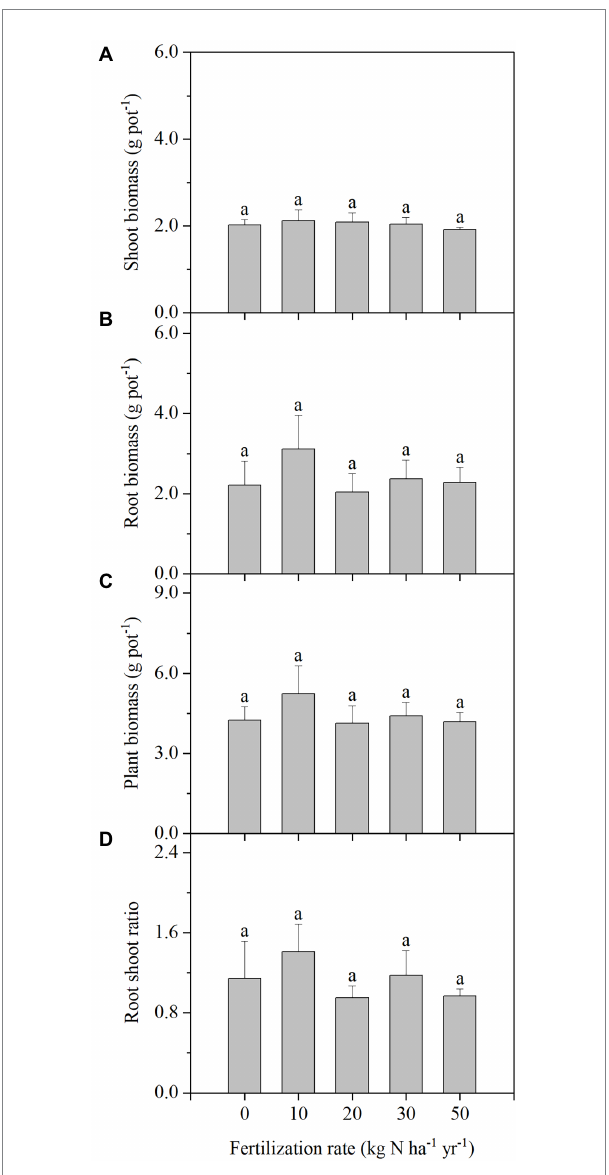
FIGURE 2 Shoot biomass (A) , root biomass (B) , plant biomass (C) , and root- shoot ratios (D) in Stipa breviflora plants grown under different N addition rates at120 DAS. Each value is the mean of four replicates (+SD). Different lowercase letters indicate significant differences among the treatments at p <